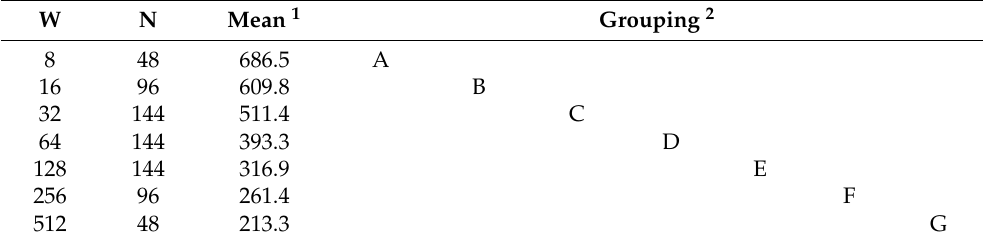
Table 4. Tukey post-hoc analysis for W and MT . MT was negatively related to W